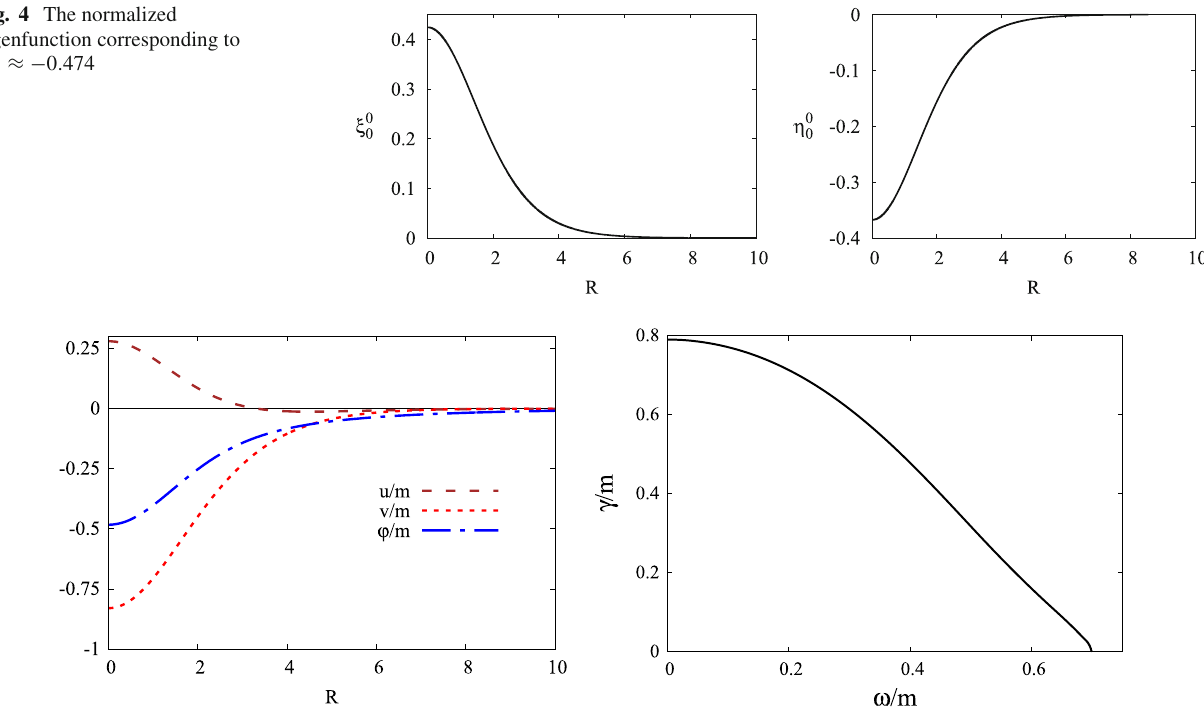
Fig. 5 The form of the instability mode for ω